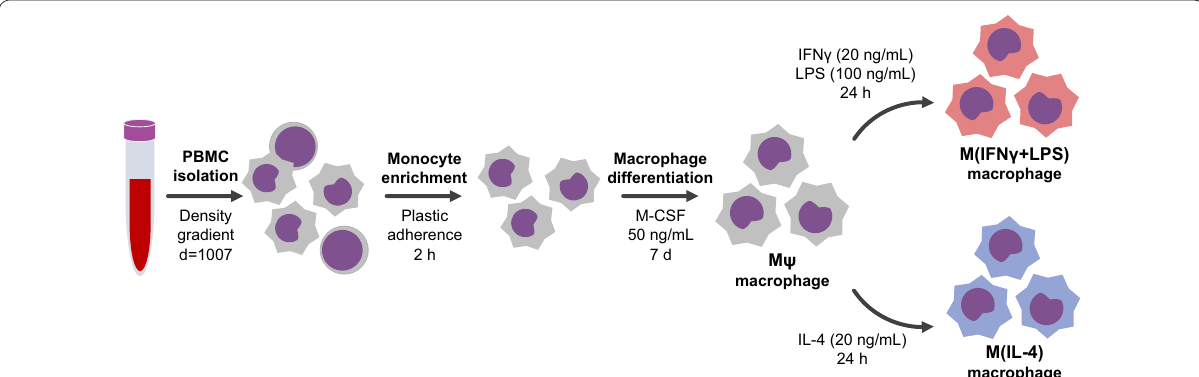
Fig. 1 Workflow of monocyte isolation, and macrophage differentiation and polarization. Approximately 3–5 late‑stage BD patients and healthy controls were seeded into 12‑well cell culture plates and allowed to adhere for 2 h in a 5% CO 2 incubator at 37 °C. Adherent cells were differentiated into macrophages in RPMI 1640 media supplemented with 10% FBS and M‑CSF, 50 ng/mL for 7 days. For classical and alternative phenotypes, M ψ were incubated for additional 24 h with